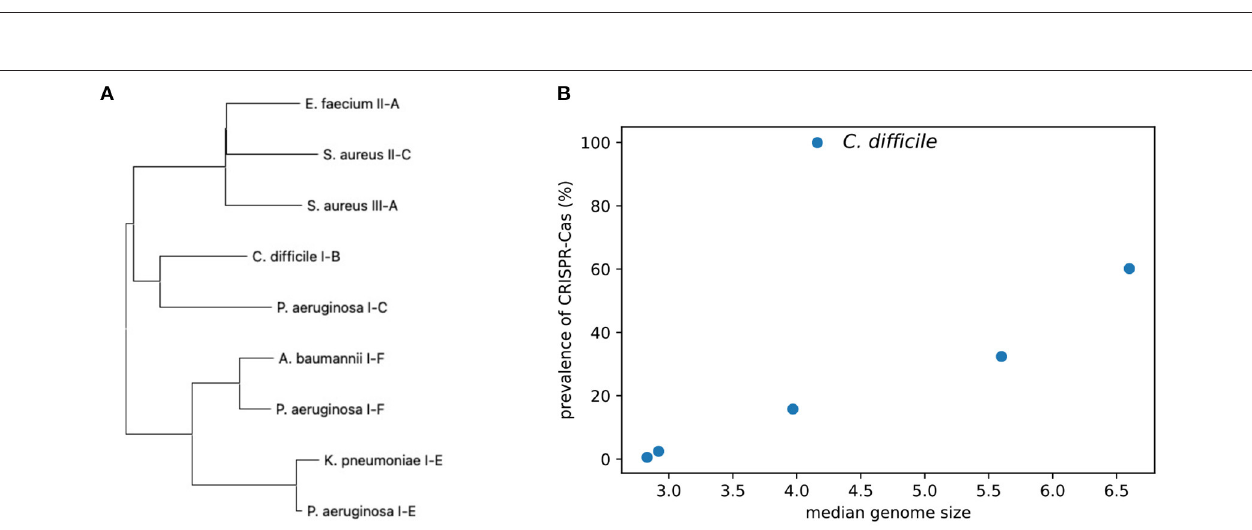
FIGURE 3 | Comparison of the CRISPR–Cas systems identified from the ESKAPE+C pathogens. (A) A phylogenetic tree of the universal cas1 genes associated with CRISPR–Cas systems. (B) Graph comparing the prevalence of CRISPR–Cas systems among ESKAPE+C pathogens and their genome size (Mb).